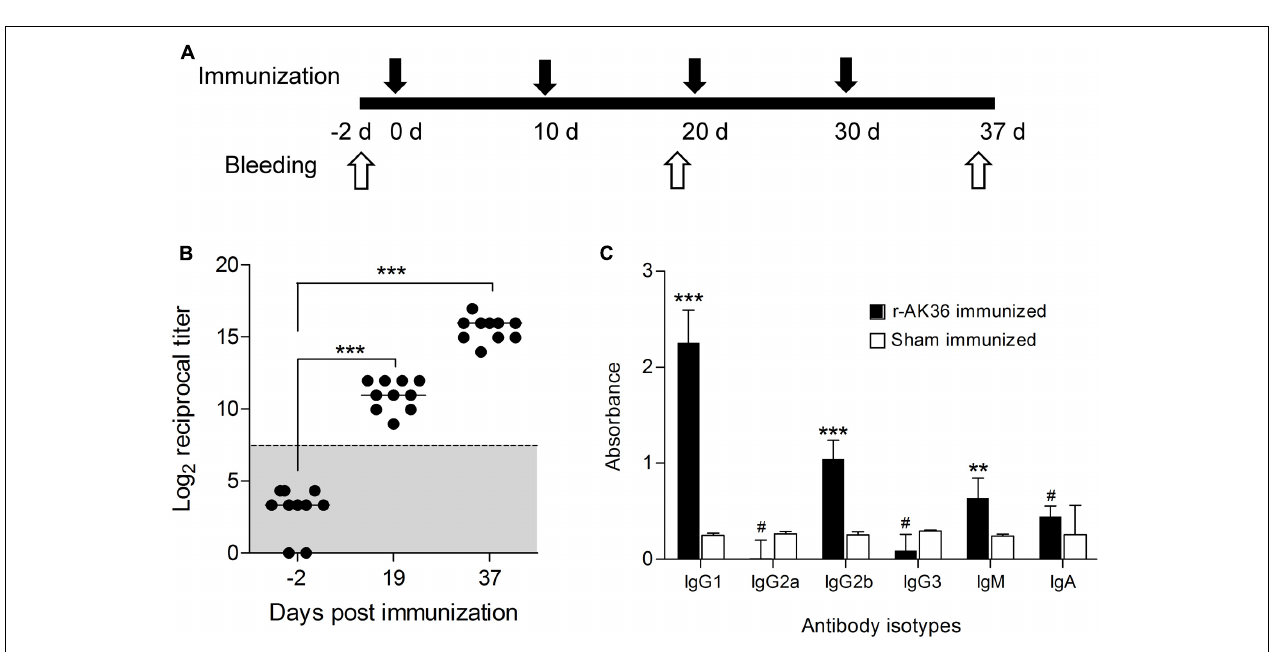
FIGURE 1 | Cloning and expression of r-AK36 fusion protein in pRSETA vector. (A) Schematic representation of PCR amplification, splicing and cloning of chimeric r-AK36 gene in pRSETA vector. (B) Agarose gel showing PCR amplified ompA and ompK36 genes and ompAK36 spliced gene. (C) Stained SDS-PAGE gel showing expressed rAK36 protein upon IPTG induction. (D) Western blot probed with anti-histidine antibodies showing 6x-His tagged r-AK36 protein. (E) SDS-PAGE gel showing r-AK36 protein from different elutions following IMAC purification with Ni-NTA agarose.